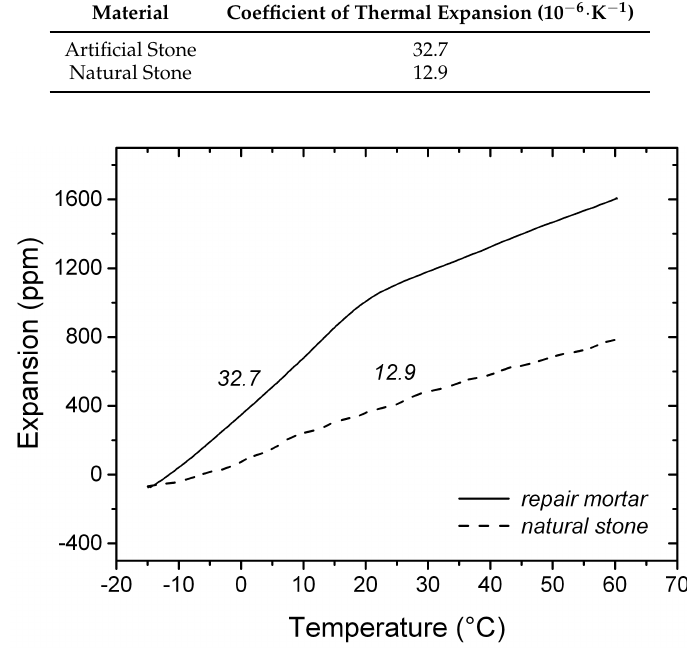
Figure 6. Thermal expansion of the natural stone (dash line) and the artificial stone (full line) measured by DMA. The coefficient of thermal expansion is reported.